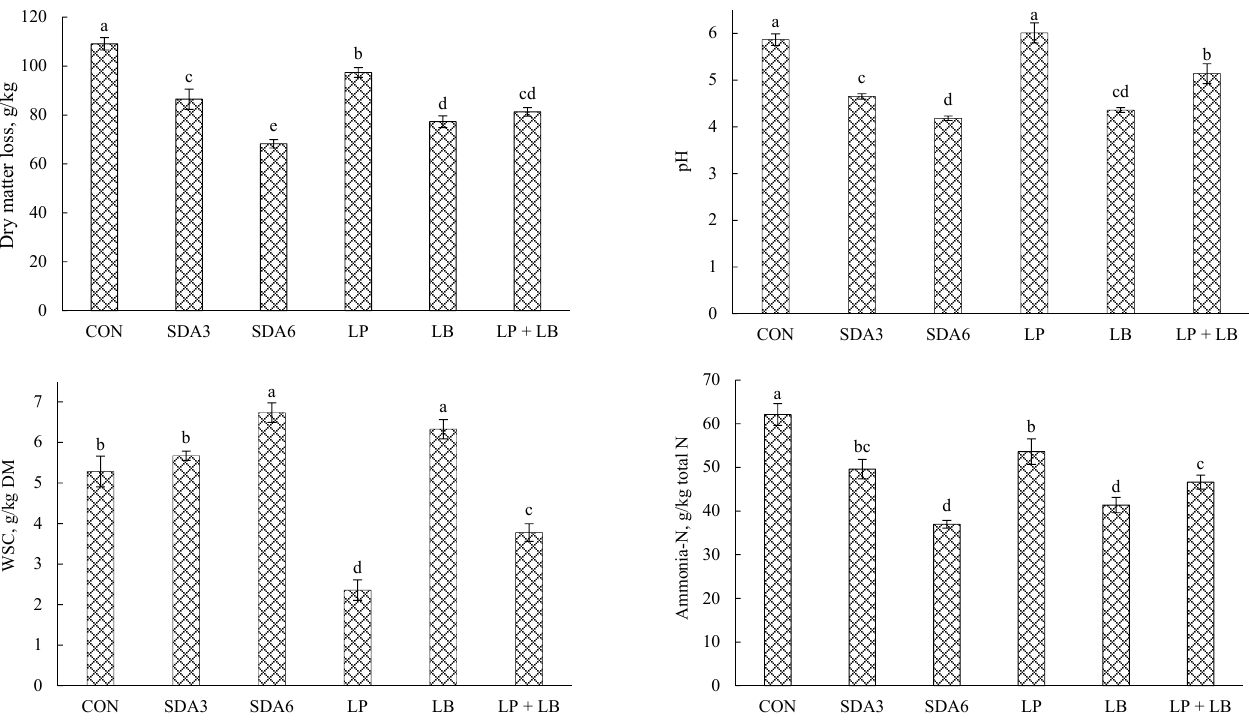
Figure 4. Dry matter loss, pH value, water-soluble carbohydrate (WSC), and ammonia-N concentration in early-harvested rye ensiled for 60 d with different additives after aerobic exposure. Experimental silages were untreated silage (CON); SDA3 = sodium diacetate at 3 g/kg fresh weight; SDA6 = sodium diacetate at 6 g/kg fresh weight; LP = L. plantarum ; LB = L. buchneri ; LP+LB = L. plantarum + L. buchneri (equal proportion). Inocu - lant application rate was 1,000,000 cfu/g fresh weight. a-e Means (±standard deviation) with unlike superscripts differ (based on Duncan’s test; p<0.05).